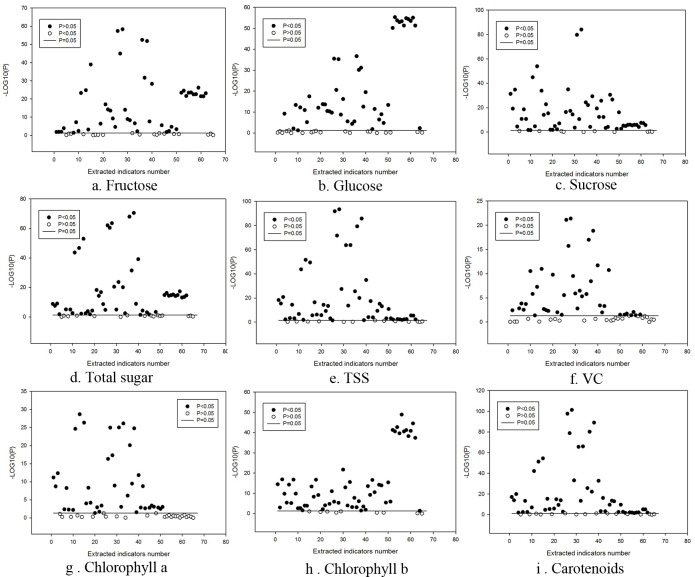
The correlation analysis between internal and external phenotypic parameters of muskmelon.The solid horizontal line represents P = 0.05, i.e.,–log10 P = 1.301. (The abscissa refers to the number of each indicator in Table 1. In order to visually show the correlation, the P value of the ordinate significance test is converted to -LOG10(P).